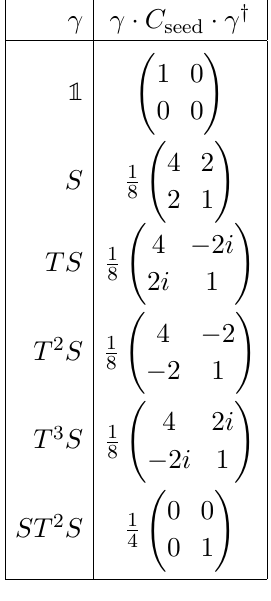
Table 1. Generators of the orbit of the vacuum